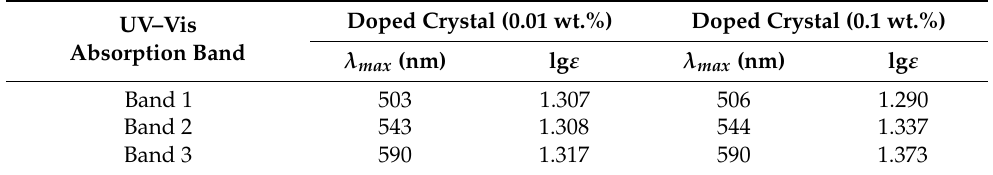
Table 6. UV–Vis characteristic bands representing pentacene in pentacene-doped p-terphenyl crystals.